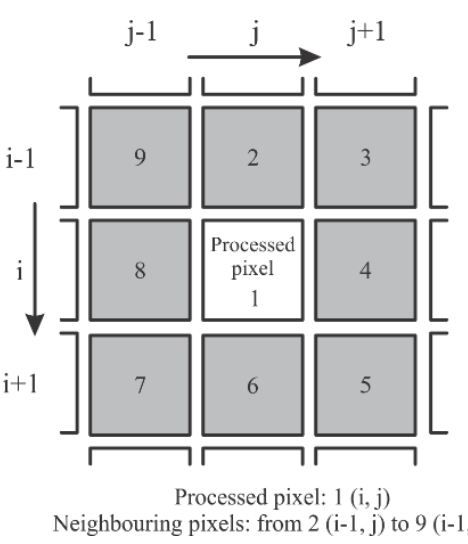
Figure 1. Designations of the nine pixels in a 3 × 3 kernel [15].